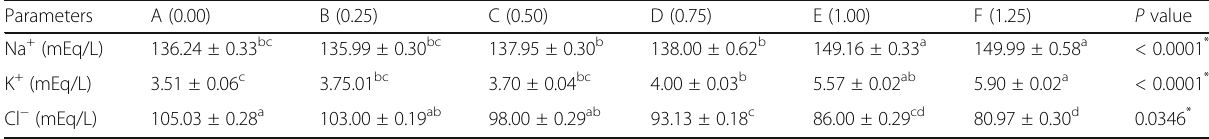
Table 3 Serum electrolyte of the broilers fed diets with different levels of MSG